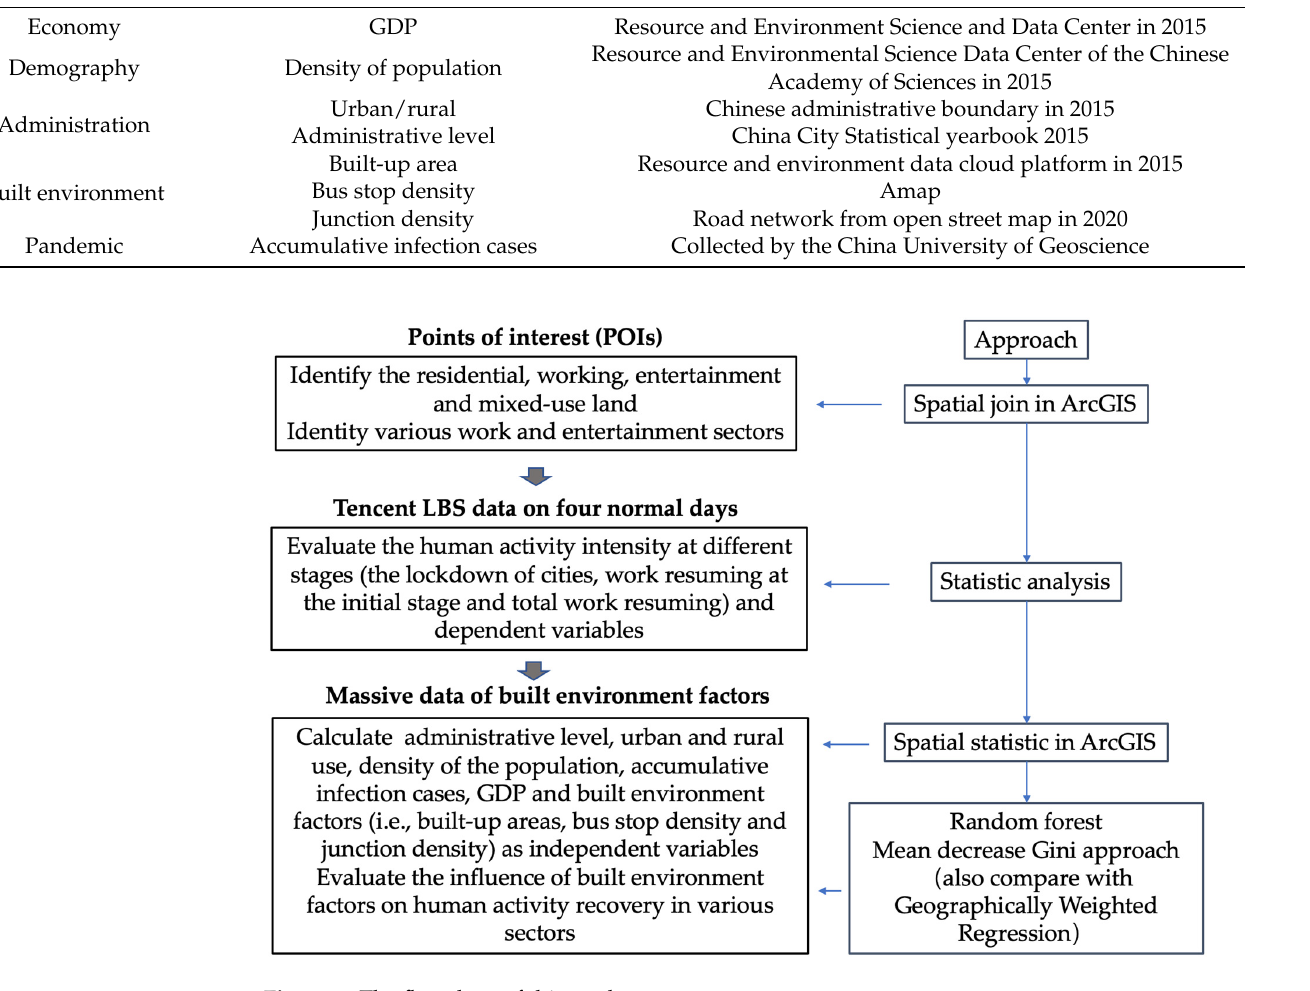
Figure 2. The flowchart of this study.